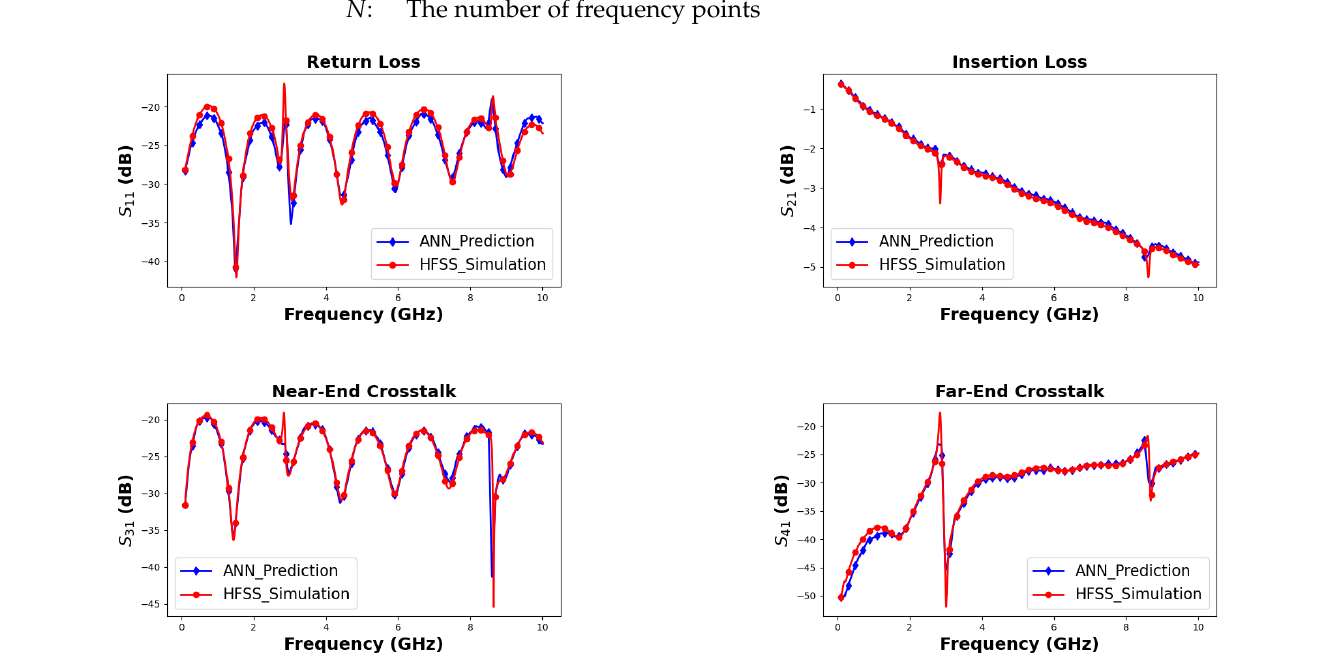
Figure 7. S-parameter prediction for the optimal structure W = 25 µ m, K D = 2.